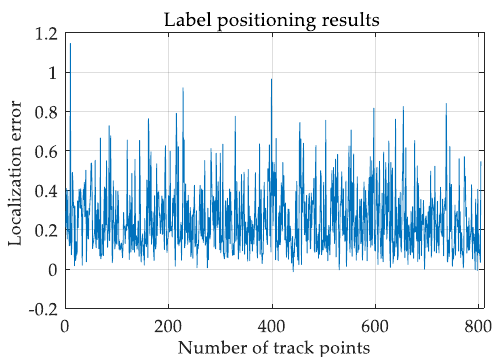
Figure 11. Label positioning results.